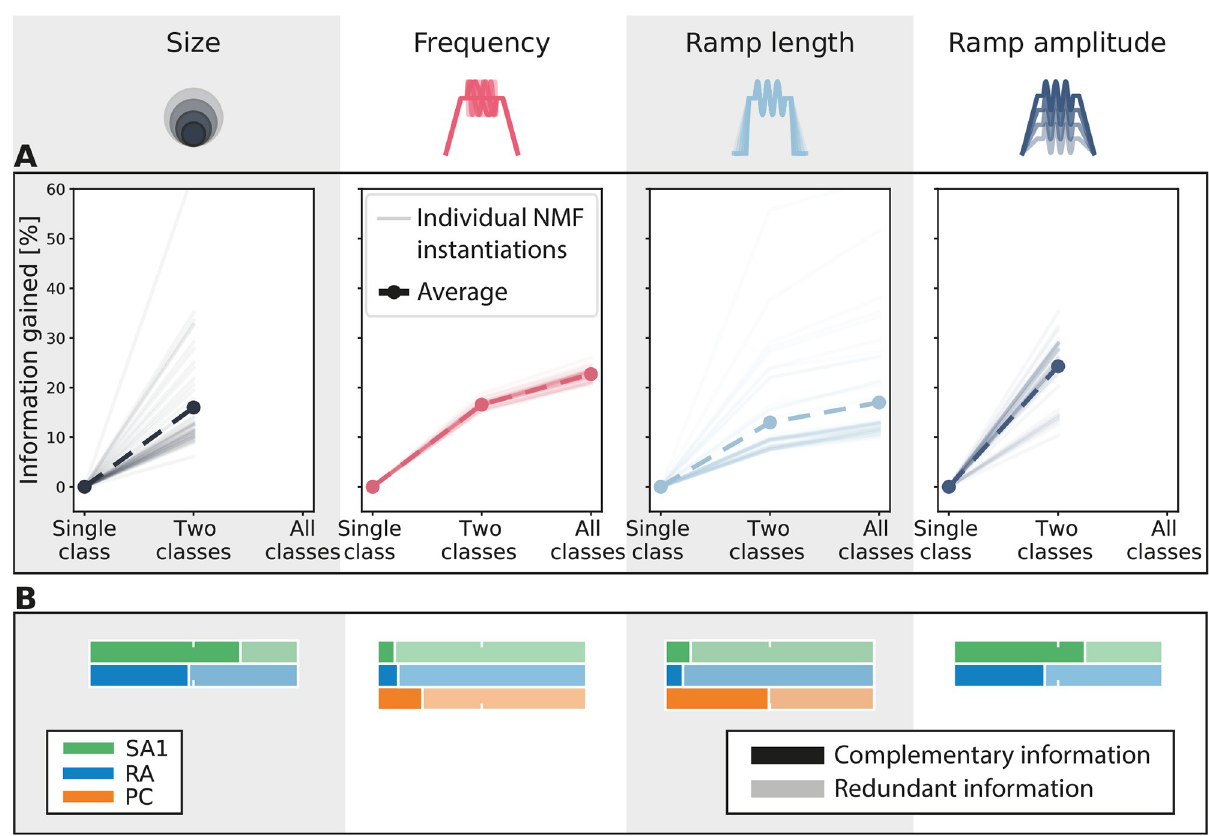
Fig 4. Integrating information across afferent classes. (A) Information gain considering the two and the three most informative classes together with respect to the most informative class alone. The density measured on the human finger was taken for each afferent class. Thin lines correspond to different instantiations of the NMF decomposition, and the thick dashed lines correspond to their averages. (B) Decomposition of information into redundant and complementary contributions of each class with respect to the remaining two classes together. Information for each afferent class has been normalized to 100% and was calculated at the density measured on the human finger. Note that in both panels (A) and (B) only two afferent classes were considered for the analyses regarding stimulus size and ramp amplitude since the third class (PC) was carrying null information (see Fig